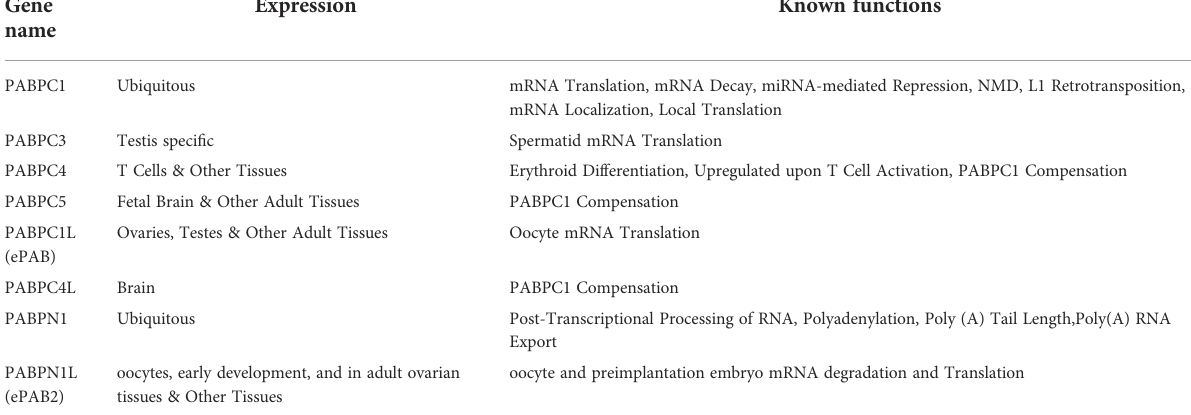
TABLE 1 The expression and known function of